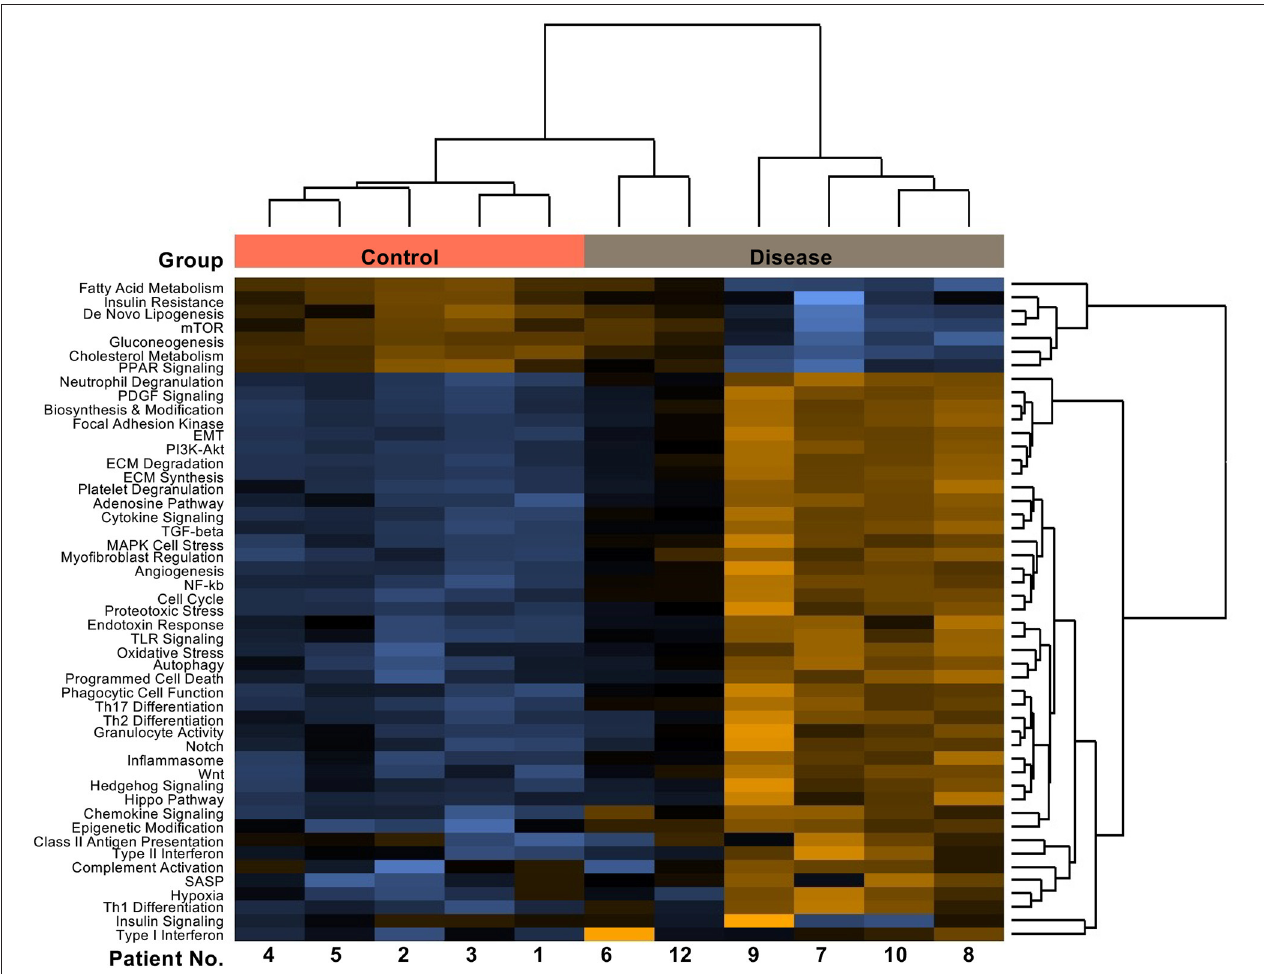
FIGURE 6 | Patients with underlying heart/lung disease display upregulated fibrotic pathways in liver biopsies. Pathway score heatmap of fibrogenic gene sets detected via nCounter® Fibrosis Panel in RNA isolated from FFPE tissues of patients with confirmed histological diagnosis of congestive hepatopathy and underlying heart disease (Disease) and patients with autoimmune hepatitis in remission as control